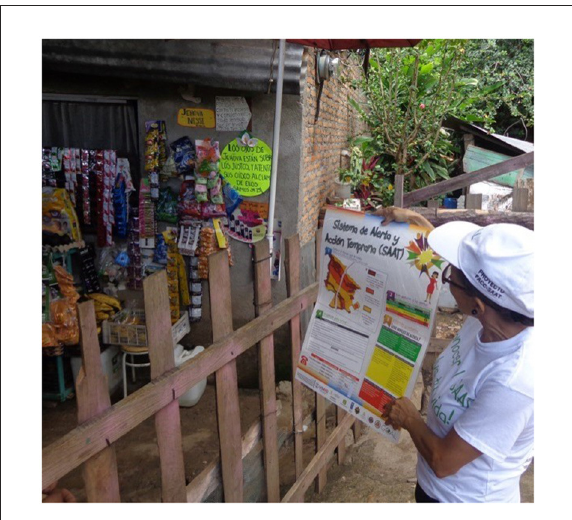
FIGURE5 A “prevention preacher” makes house-to-house visits to raise awareness and knowledge about the EWRS. Credit: GOAL, 2016.